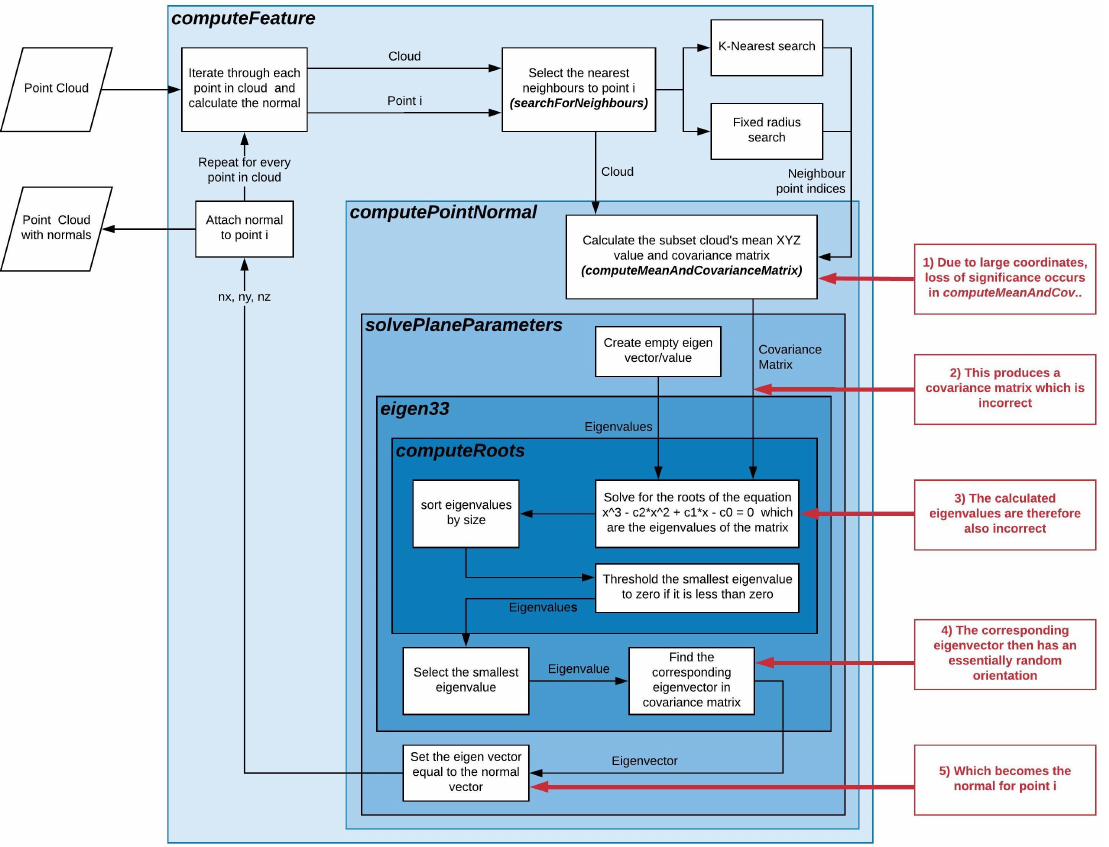
Figure 2. Flow diagram outlining the PCL process for calculating point normals and how LoS causes them to be calculated inaccurately. The key stages of the numerical precision issue are shown in the red text boxes. Names of the relevant functions are shown in bold